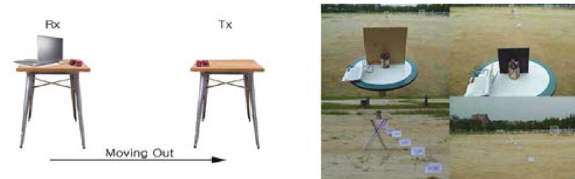
Fig. 1. experimental